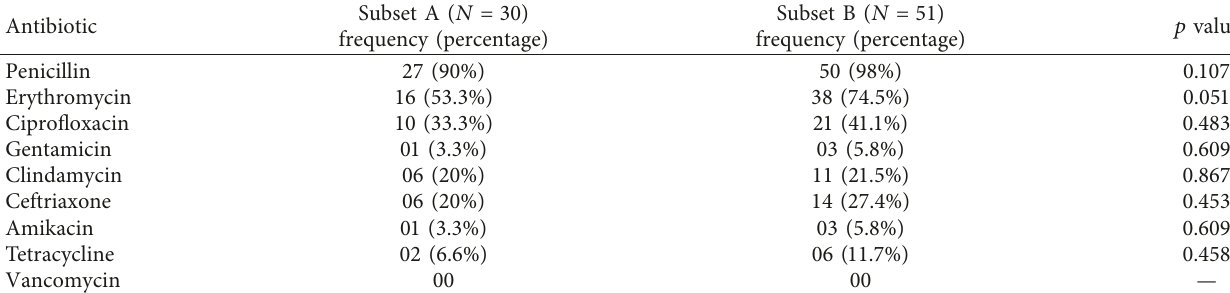
Table 3: Antibiotic resistance pattern of Staphylococcus aureus isolates from nasal and pharyngeal specimens.